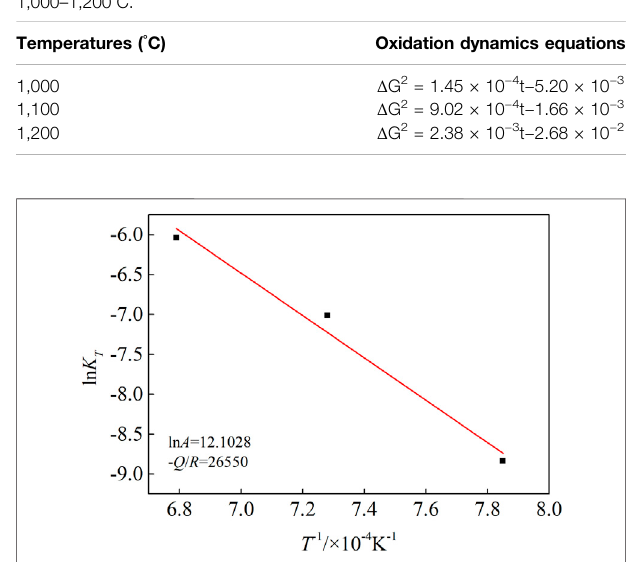
Figure 5 is obtained. And the slope ln A (cid:1) 12.10 and the intercept -Q/R (cid:1) 26,550 are obtained. The values of A and Q are calculated